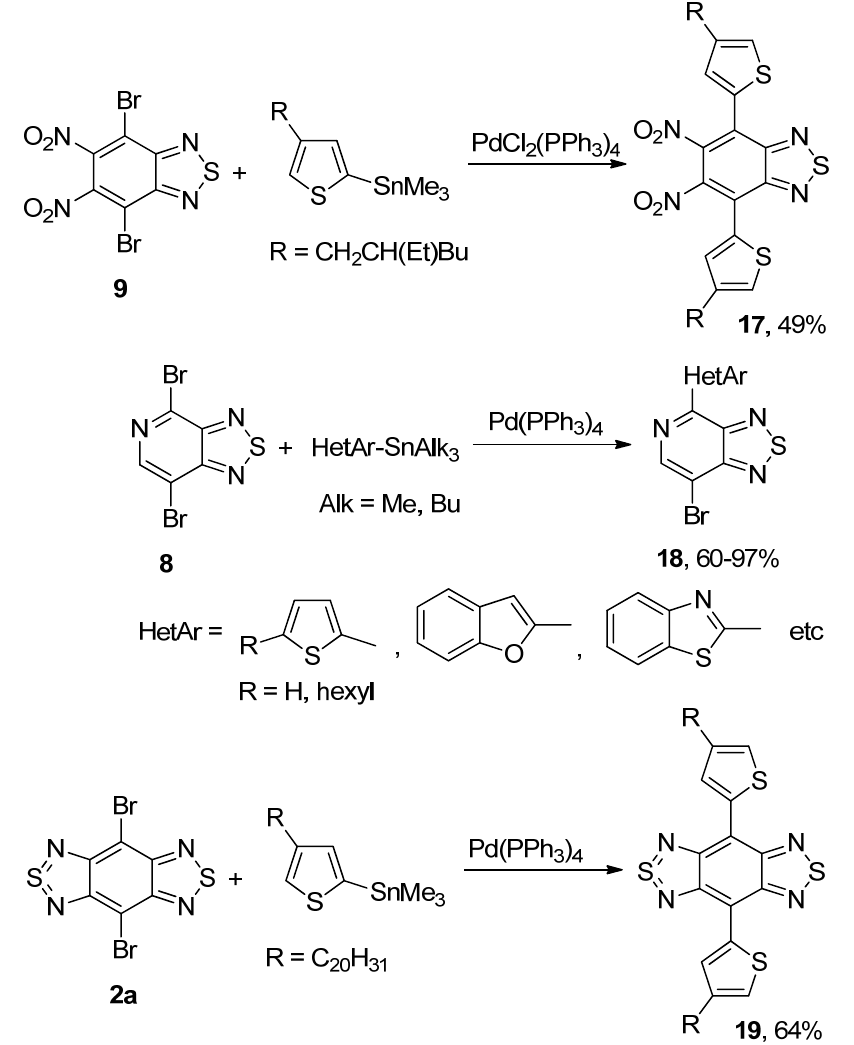
Scheme 8. Synthesis of thienyl-substituted 2,1,3-benzo(pyrido)thiadiazoles and related compounds 17 – 19 by the Stille